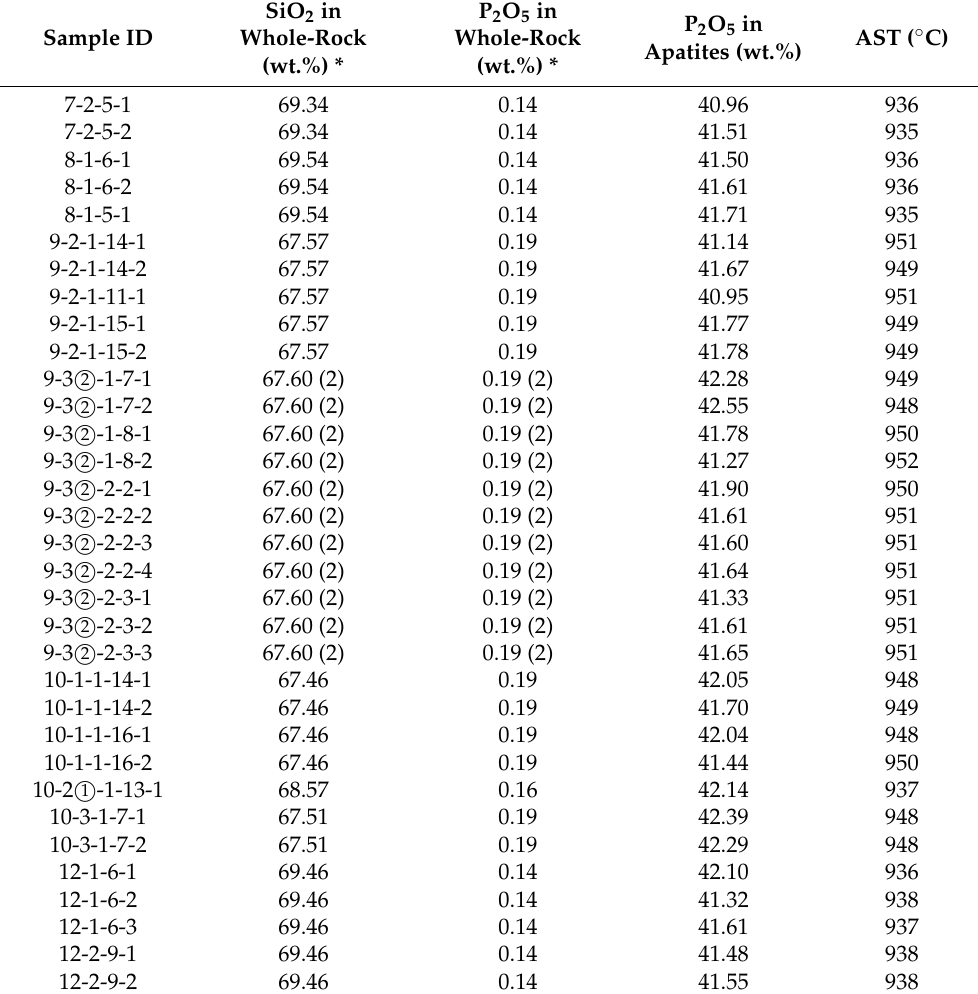
Table 1. Apatite saturation temperatures of apatite